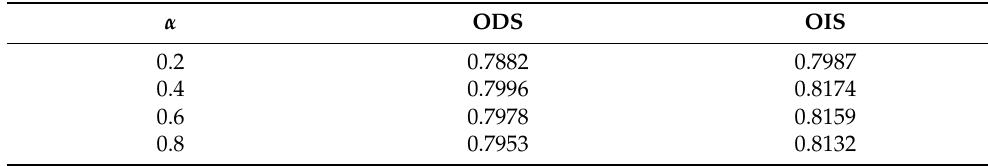
Table 5. Effect of coefficient α